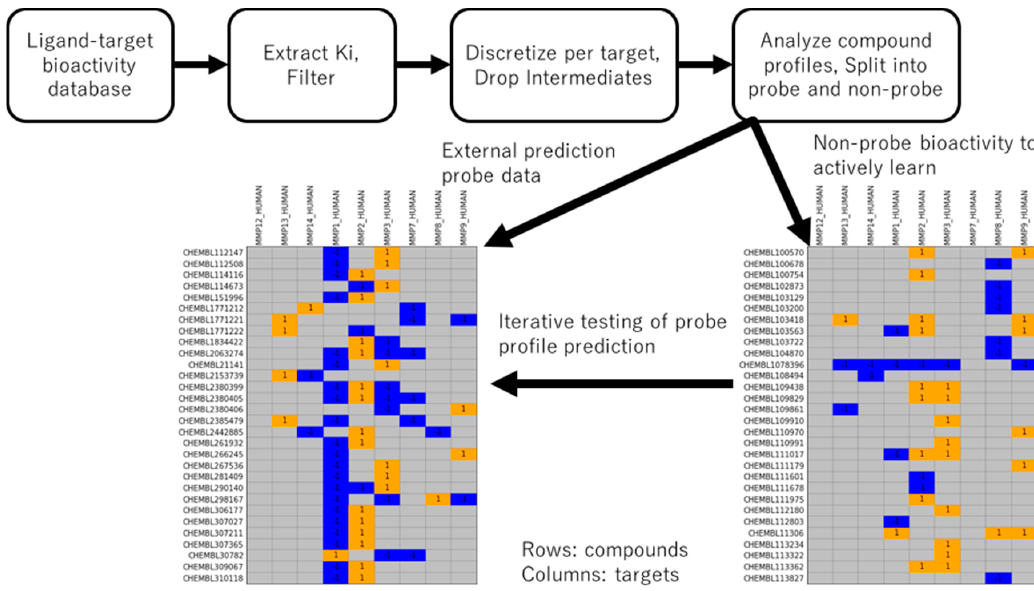
Figure 1. Extraction of bioactivity data and division into probe and non-probe datasets. MMP Ki bioactivity is extracted, filtered to ligand-target pairs with consistent measurement, discretized by a 30-fold difference in activity per target, and compounds are classified as probes or non-probes based on remaining data. Probes contain exactly one active annotation and at least one non-active annotation. Table 1. Sizes of MMP non-probe (training) and probe (external prediction) datasets used in the